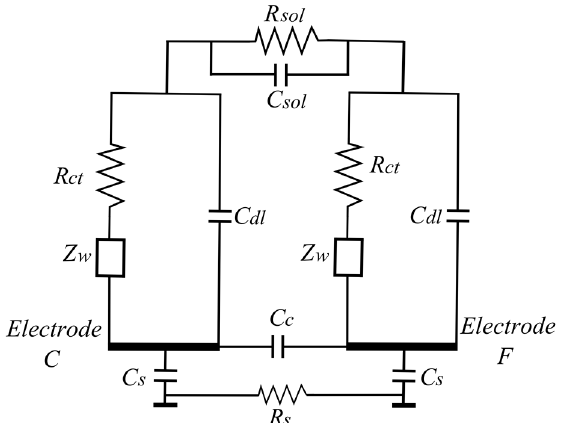
Figure 6. Equivalent circuit model for representation of the impedance measurement applying two electrodes.